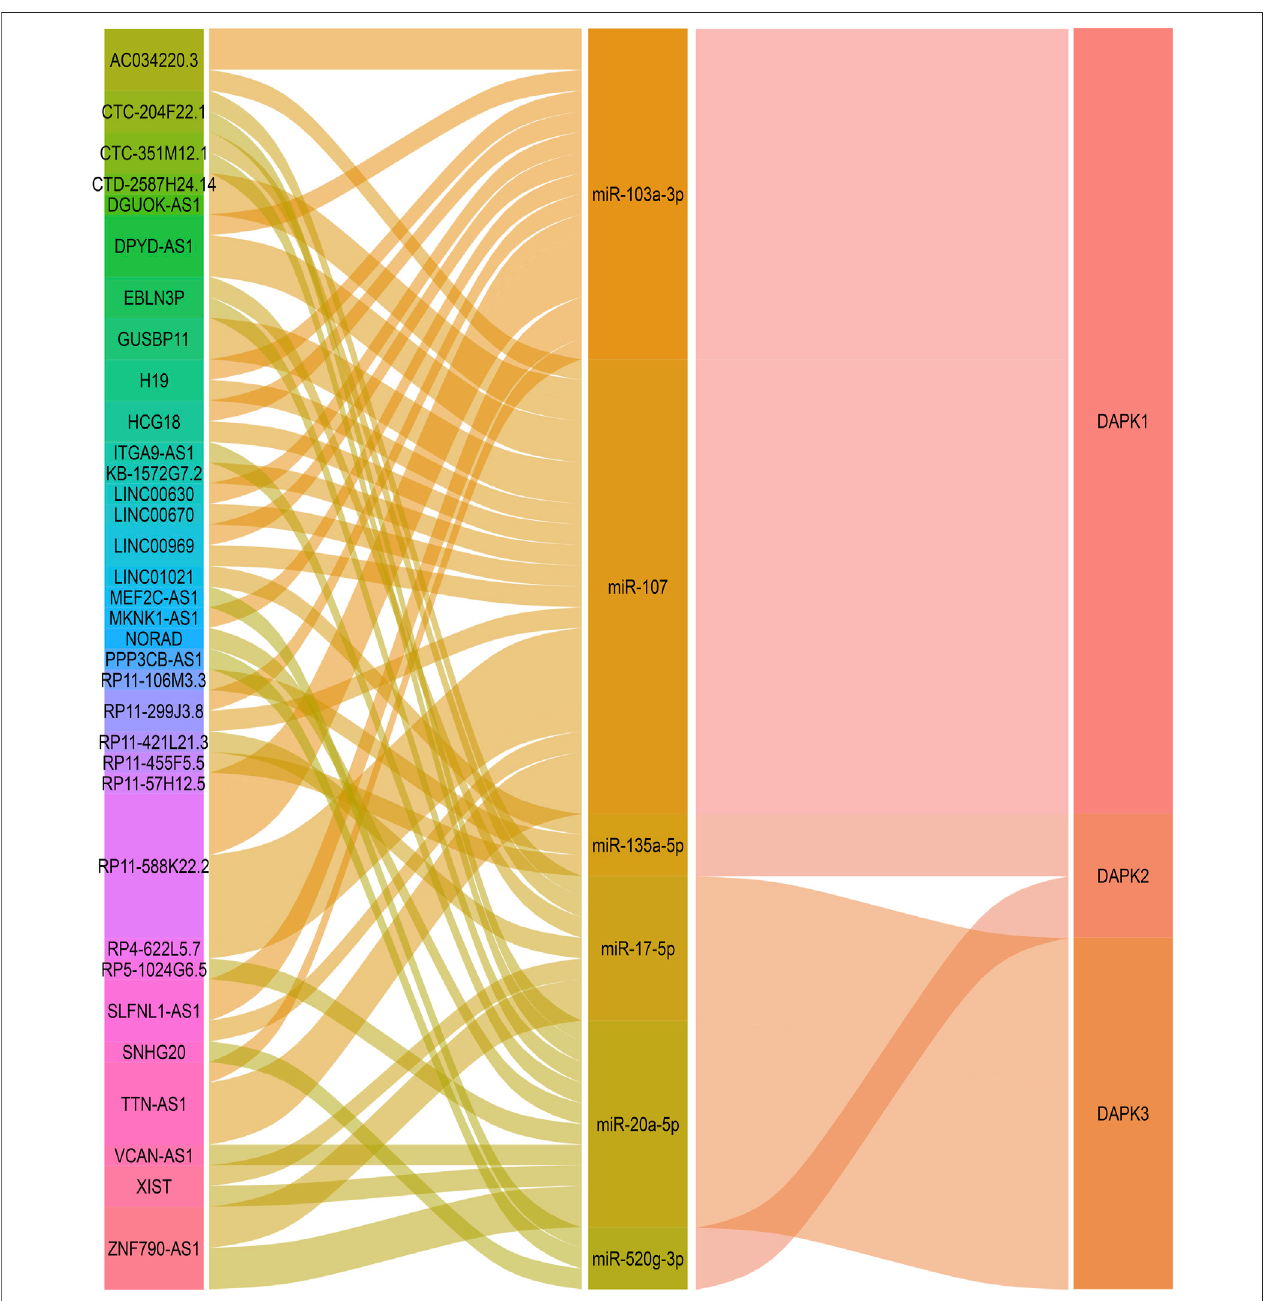
FIGURE5| BioinformaticsanalysisofpotentiallncRNAsintheregulationofDAPKs.SankeydiagramfortheceRNAnetworkinDAPK1.Eachrectanglerepresentsa gene, and the connection degree of each gene is visualized based on the size of the rectangle.